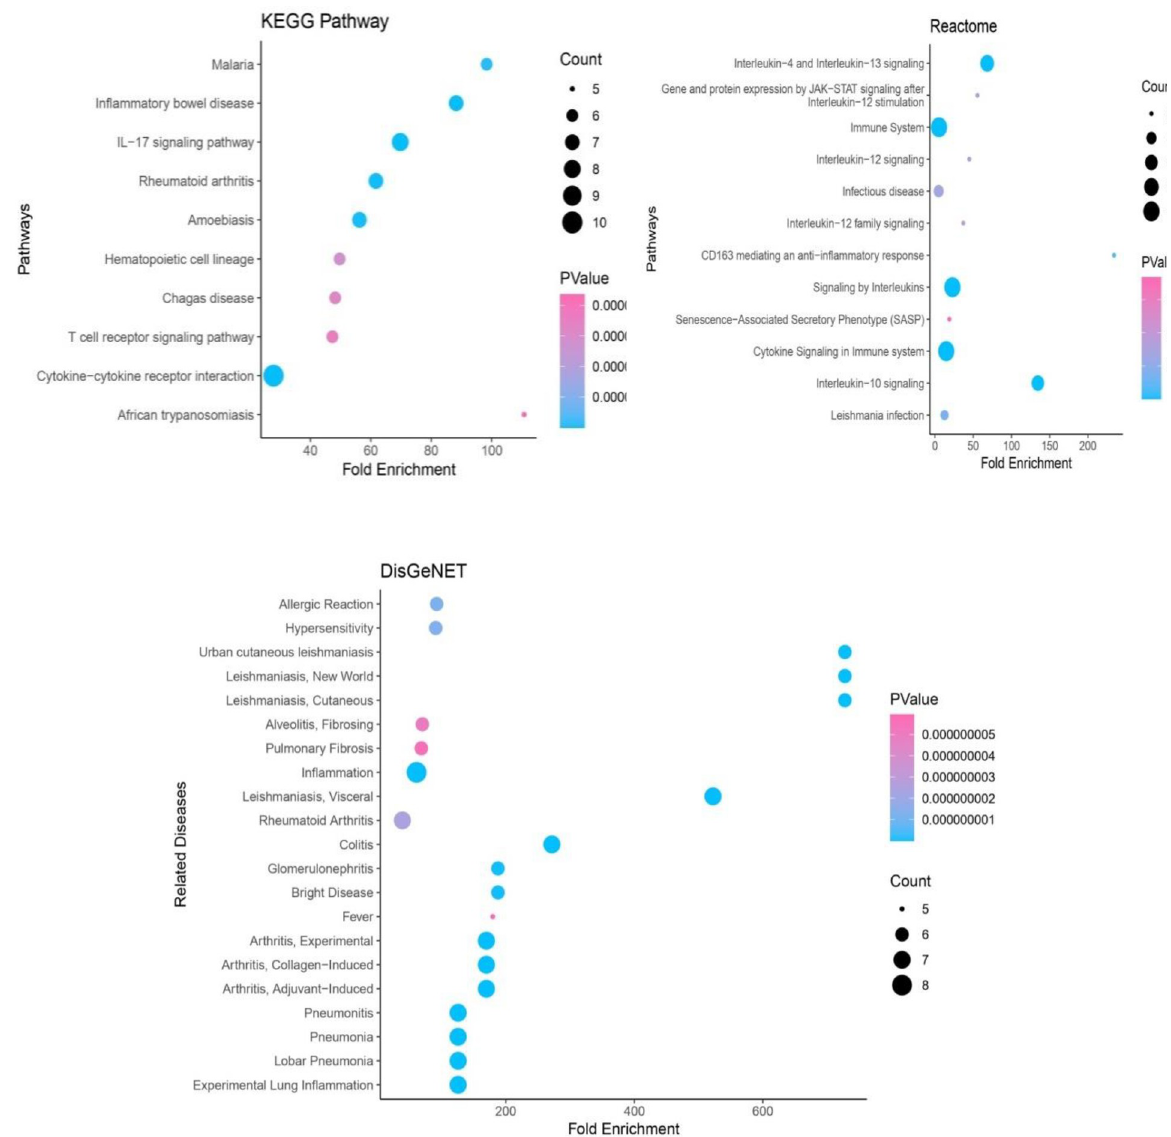
Fig 6. Bubble plot of the pathway enrichment analysis (KEGG and Reactome pathways) and DisGeNET (information on other diseases associated with the hub genes) of the resultant hub genes using DAVID. Fold Enrichment in the DAVID tool refers to the ratio of two